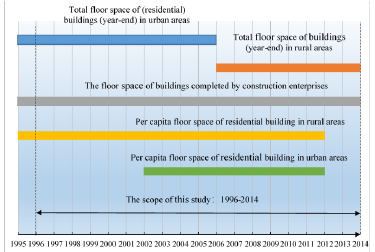
Figure 4. Sketch map of the data loss level of the statistical indicators regarding the building-related floor